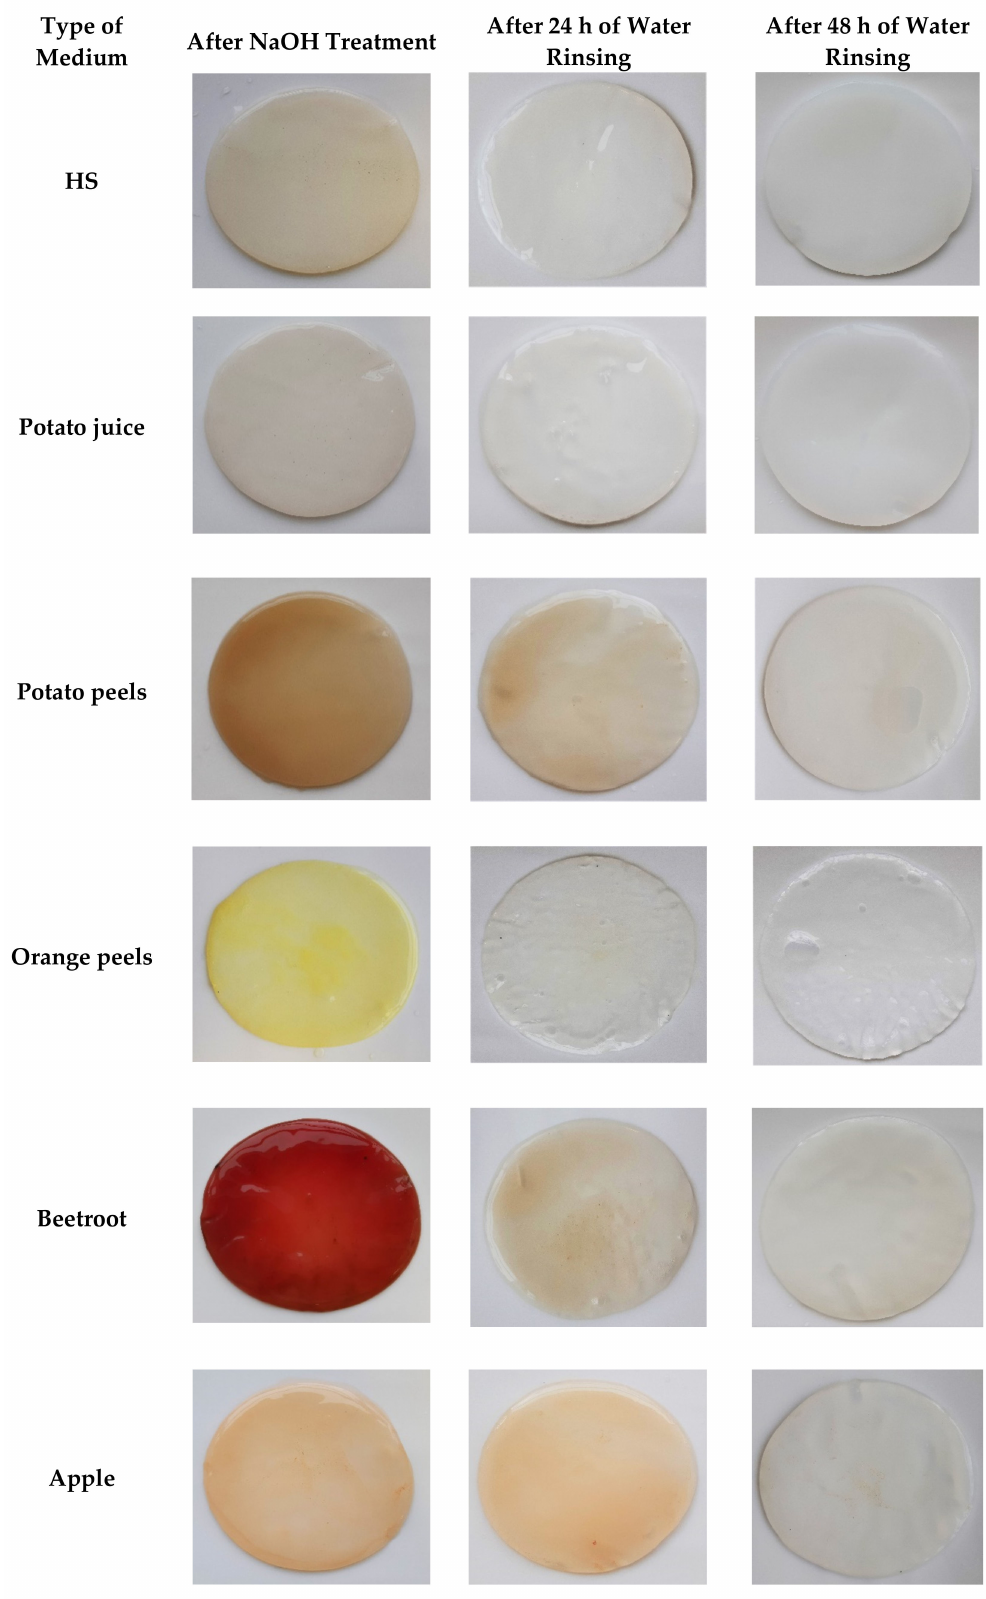
Figure 6. BC obtained from K. xylinus ATCC ATCC 53524 in HS and natural ingredients-based media in subsequent stages of